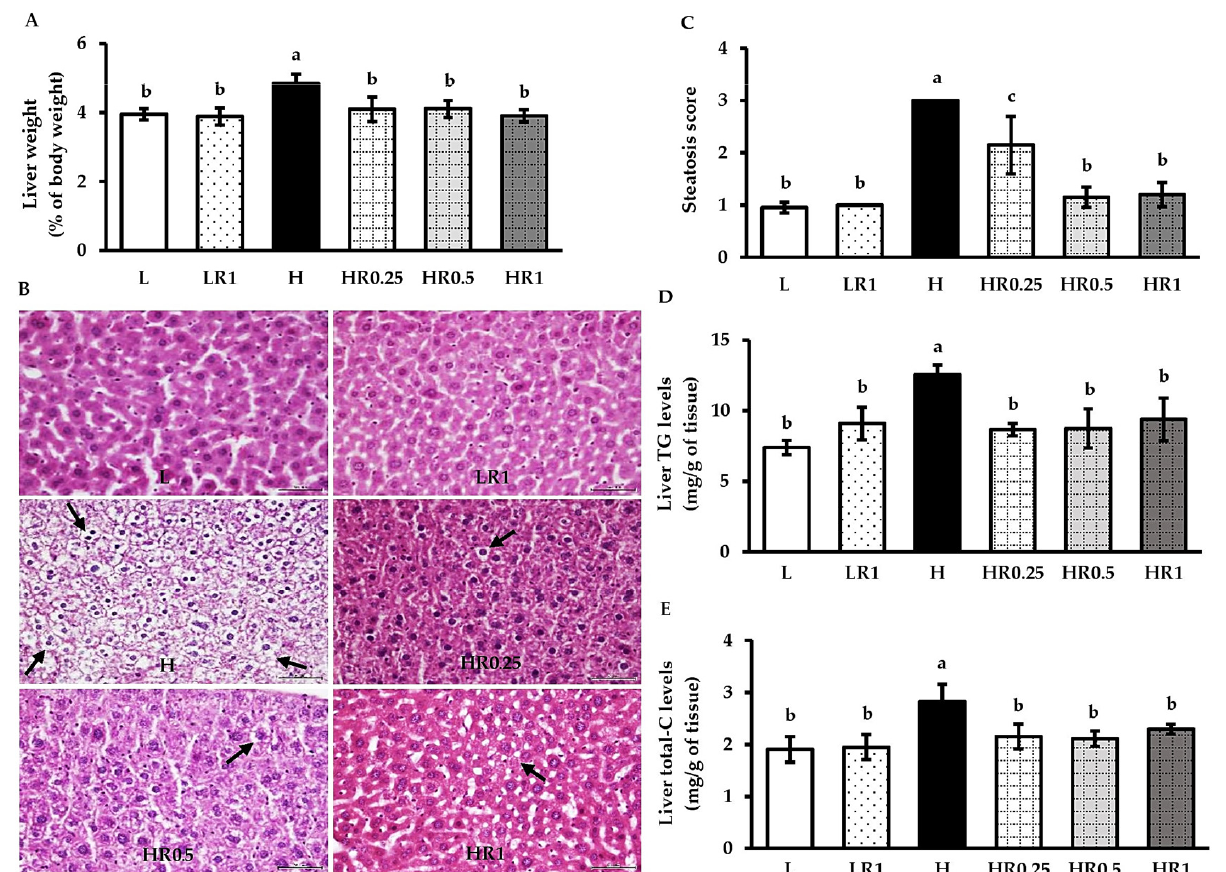
Figure 2. Effects of RRBE on indicators of hepatic steatosis in mice fed with experimental diets: ( A ) liver/body weight ratio; ( B ) representative photomicrographs of H and E-stained liver sections showing the lipid vacuoles (black arrows; × 400 magnification, bar length = 50 µ m); ( C ) steatosis score; ( D ) liver TG content; ( E ) liver total-C content. Values are means ± SD; 6 mice/group. Statistically significant difference at p < 0.05 was analyzed using one-way ANOVA with Tukey’s test and is indicated by different letters above error bars. The L, LFD, and distilled water co-treated group; LR1, LFD, and high-dose (1 g/kg) RRBE co-treated group; H, HFD, and distilled water co-treated group; HR0.25, HFD, and low-dose (0.25 g/kg) RRBE co-treated group; HR0.5, HFD, and middle-dose (0.5 g/kg) RRBE co-treated group; HR1, HFD, and high-dose RRBE co-treated